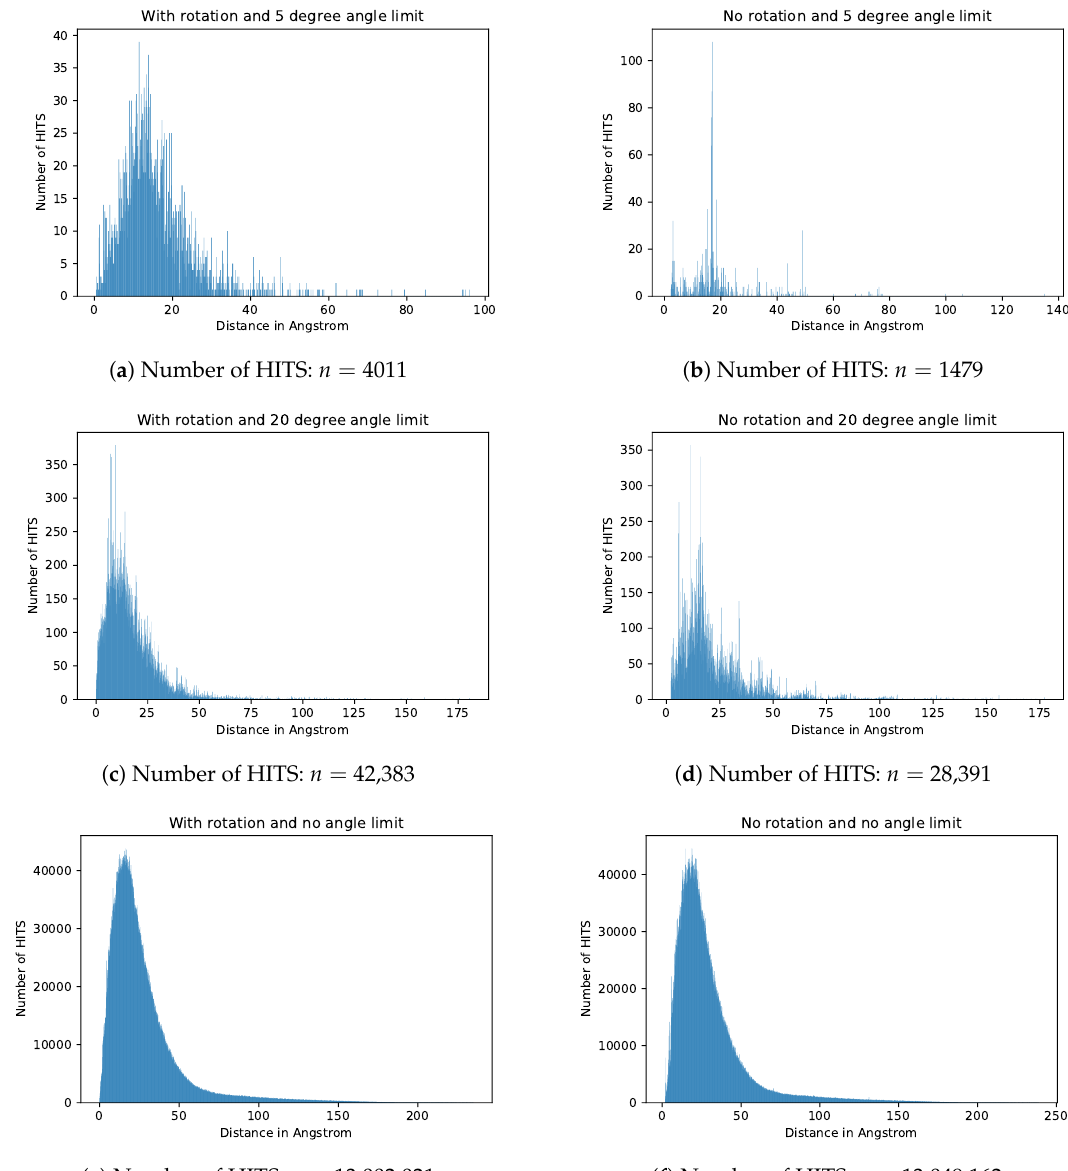
Figure 12. Screening of all occurring distances. Number of bins are ten times the maximum distance each. The individual figures ( a – f ) display different choices of screening parameters as labeled in the respective